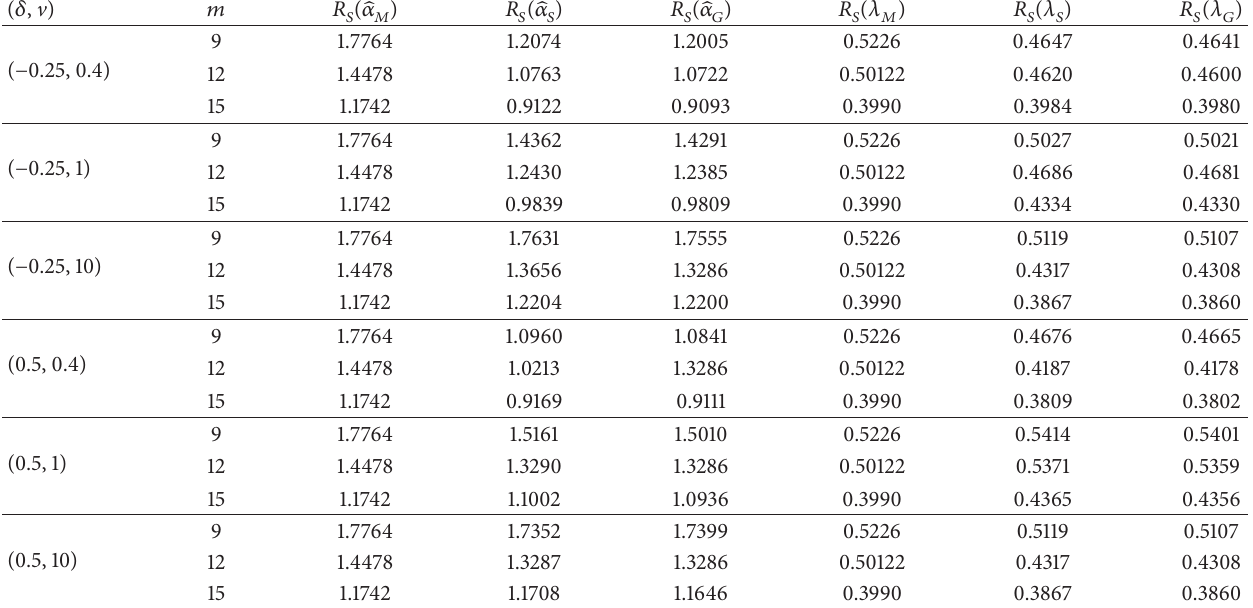
Table 3: Risks of estimators of 𝛼 and 𝜆 under SELF for fixed, 𝑛 = 15 , 𝛼 = 2 , 𝜆 = 2 , and 𝑝 = 0.5